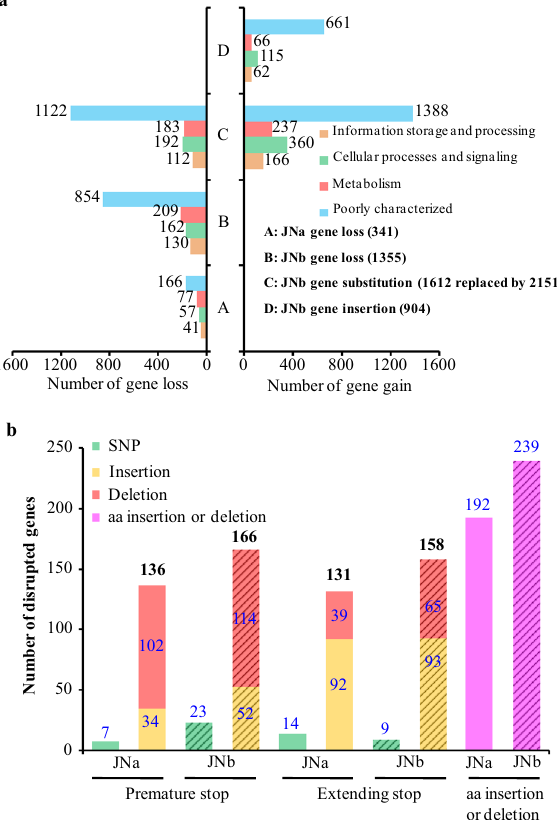
Fig. 4 Comparison of gene loss and disruption in the JN subgenomes (JNa and JNb). a Gene loss or gain was estimated based on the gene synteny of JNa or JNb in relation to LY. Gene substitution in JNb was that a syntenic fragment was replaced by another fragment containing more or fewer genes in relation to LY. Numbers of gene variations were divided into KOG categories and shown in the fi gure. b Distribution of disrupted genes by SNPs and InDels in JN subgenomes. Gene disruptions were produced by SNPs and nucleotide insertions or deletions, leading to premature or extending stop codons, and amino acid (aa) insertion or deletion compared with the LY syntenic genes. The numbers on the tops of the columns were the total genes modi fi Fig. 16b). The results revealed that the differentially expressed dominance genes evolved faster than the neutral genes, with subordinate genes even faster.